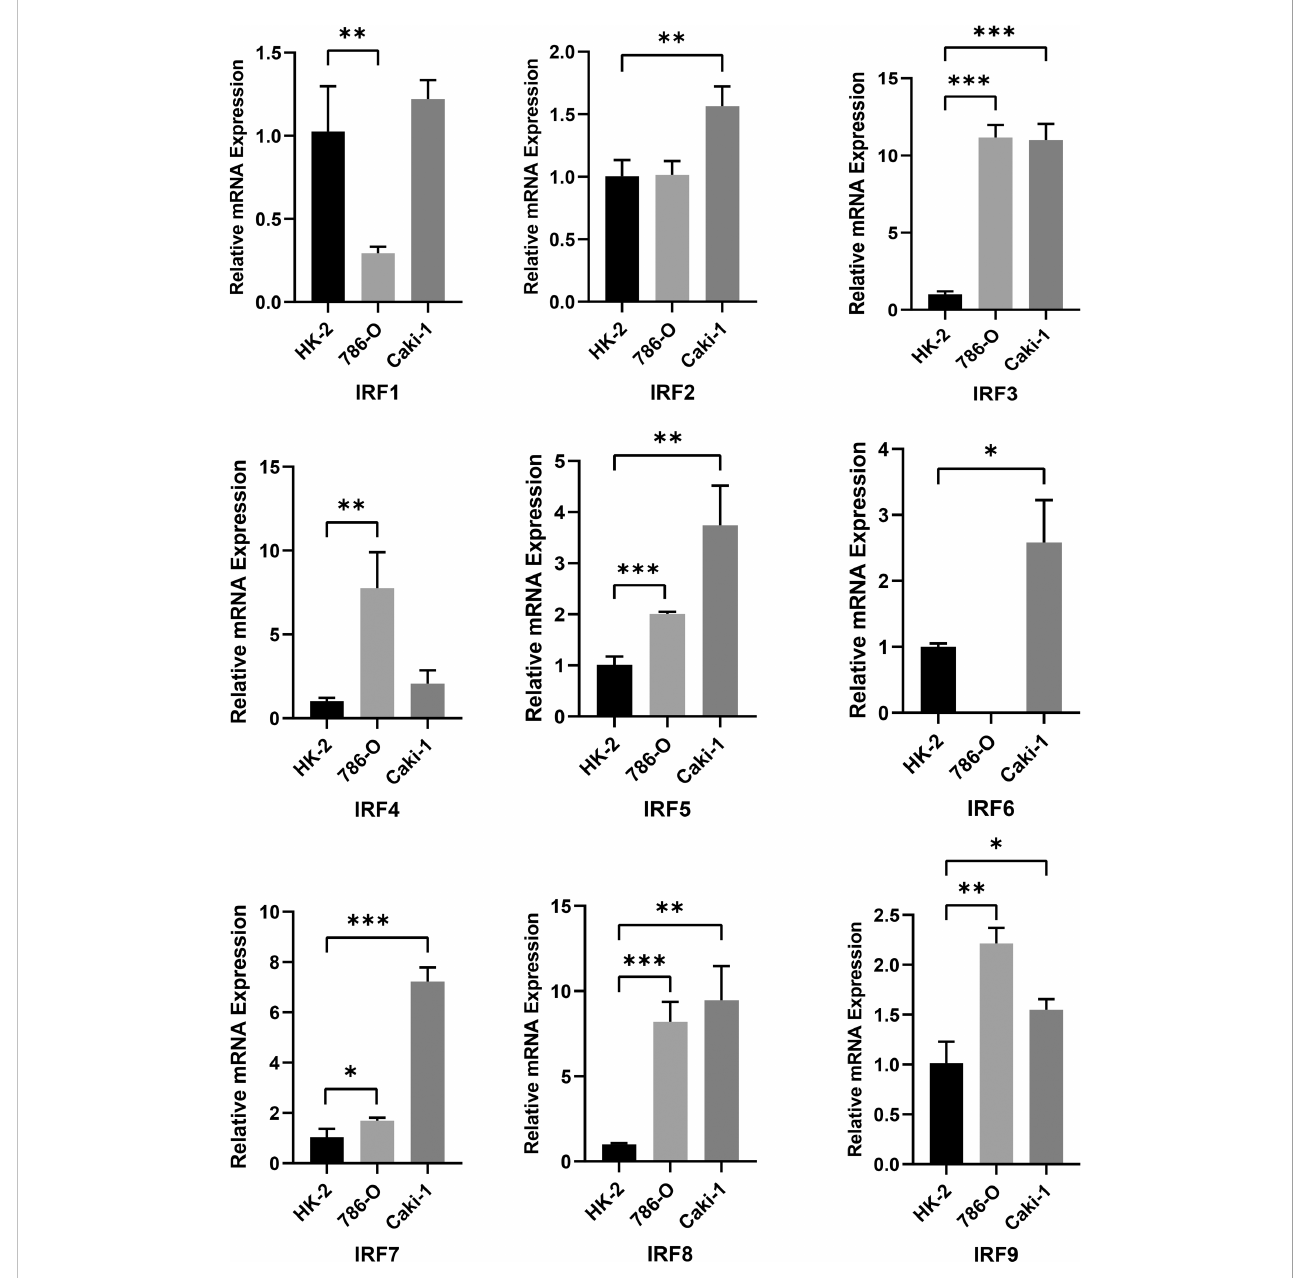
FIGURE 2 RT-PCR analysis of IRF1-9 expression levels in 786-O, Caki-1 and HK-2 cells. *P < 0.05, **P < 0.01, ***P <